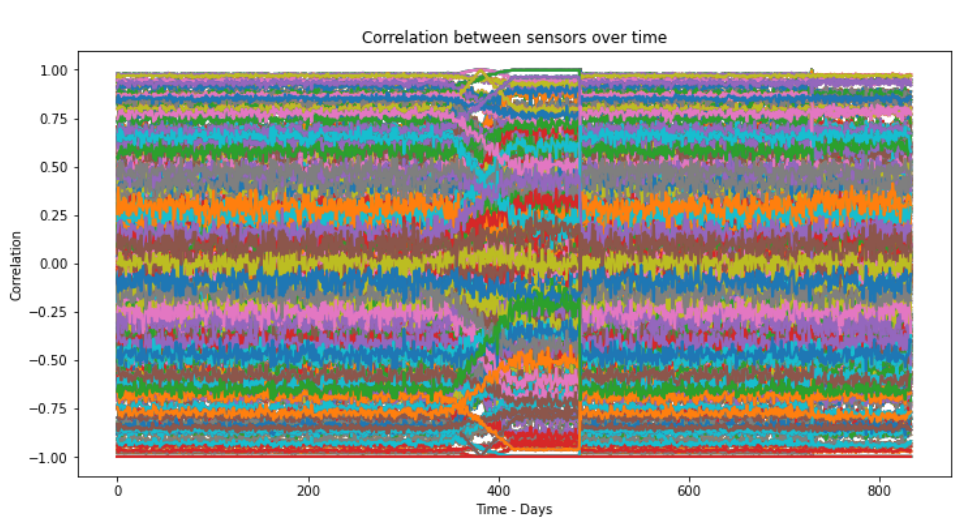
Figure 3. Correlations between each sensor pair over signal